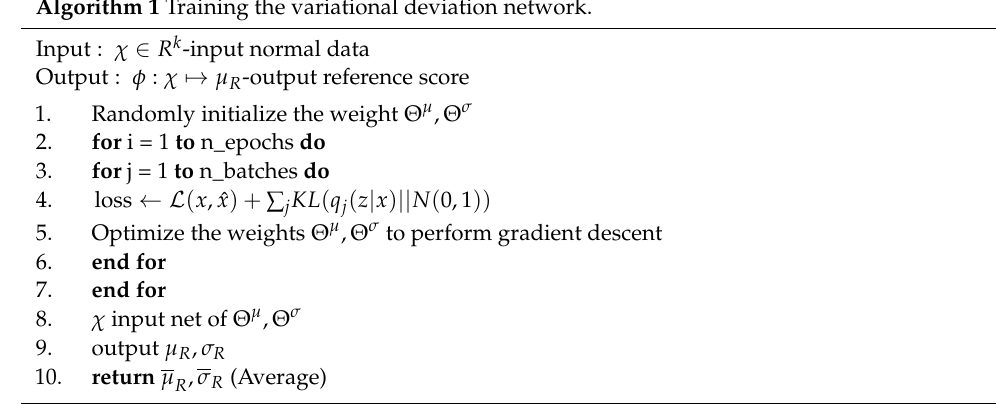
Algorithm 1 Training the variational deviation network.